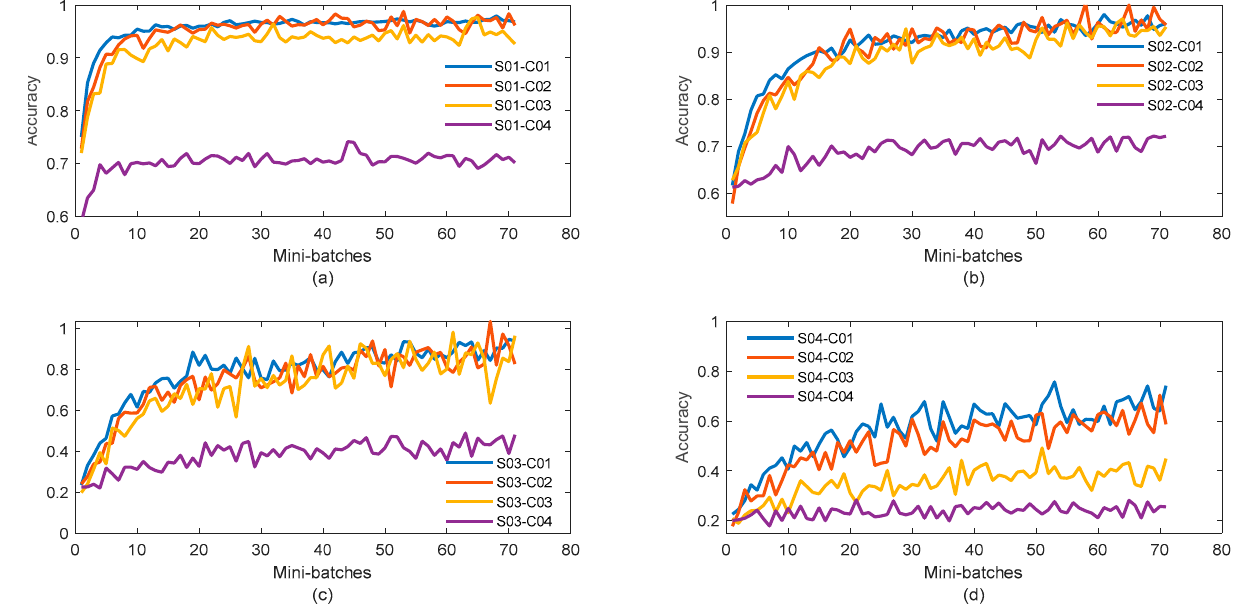
Figure 4. FTL-RLS classification performances: ( a – d ) Classification accuracy variation for subset S01, S02, S03, and S04 respectively.